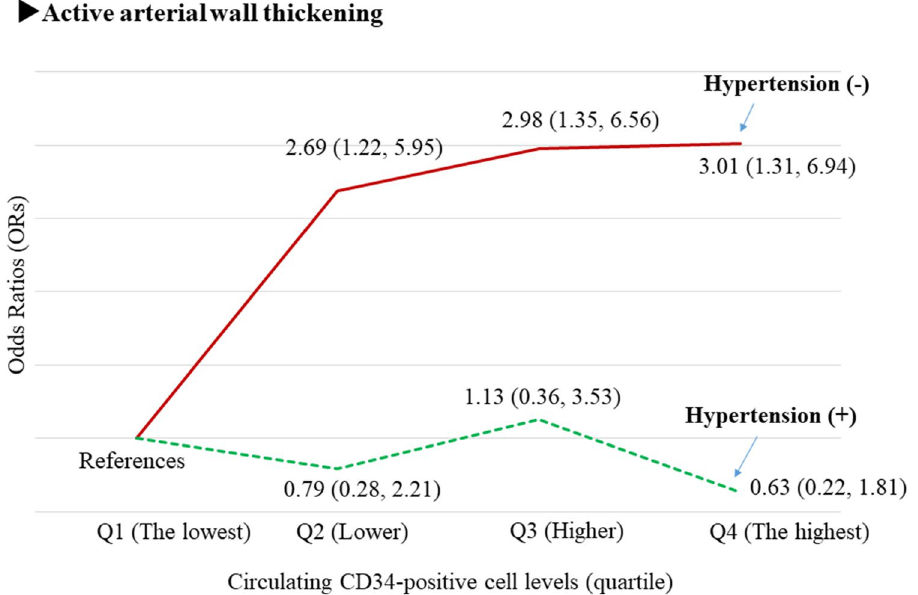
Figure 2. Associations between circulating CD34-positive cell levels and active arterial wall thickening 23 . Active arterial wall thickening: yearly increased CIMT value at and above 0.01 mm. Q1: The lowest quartile level. Q2: Lower quartile level, Q3: Higher quartile level. Q4: The highest quartile